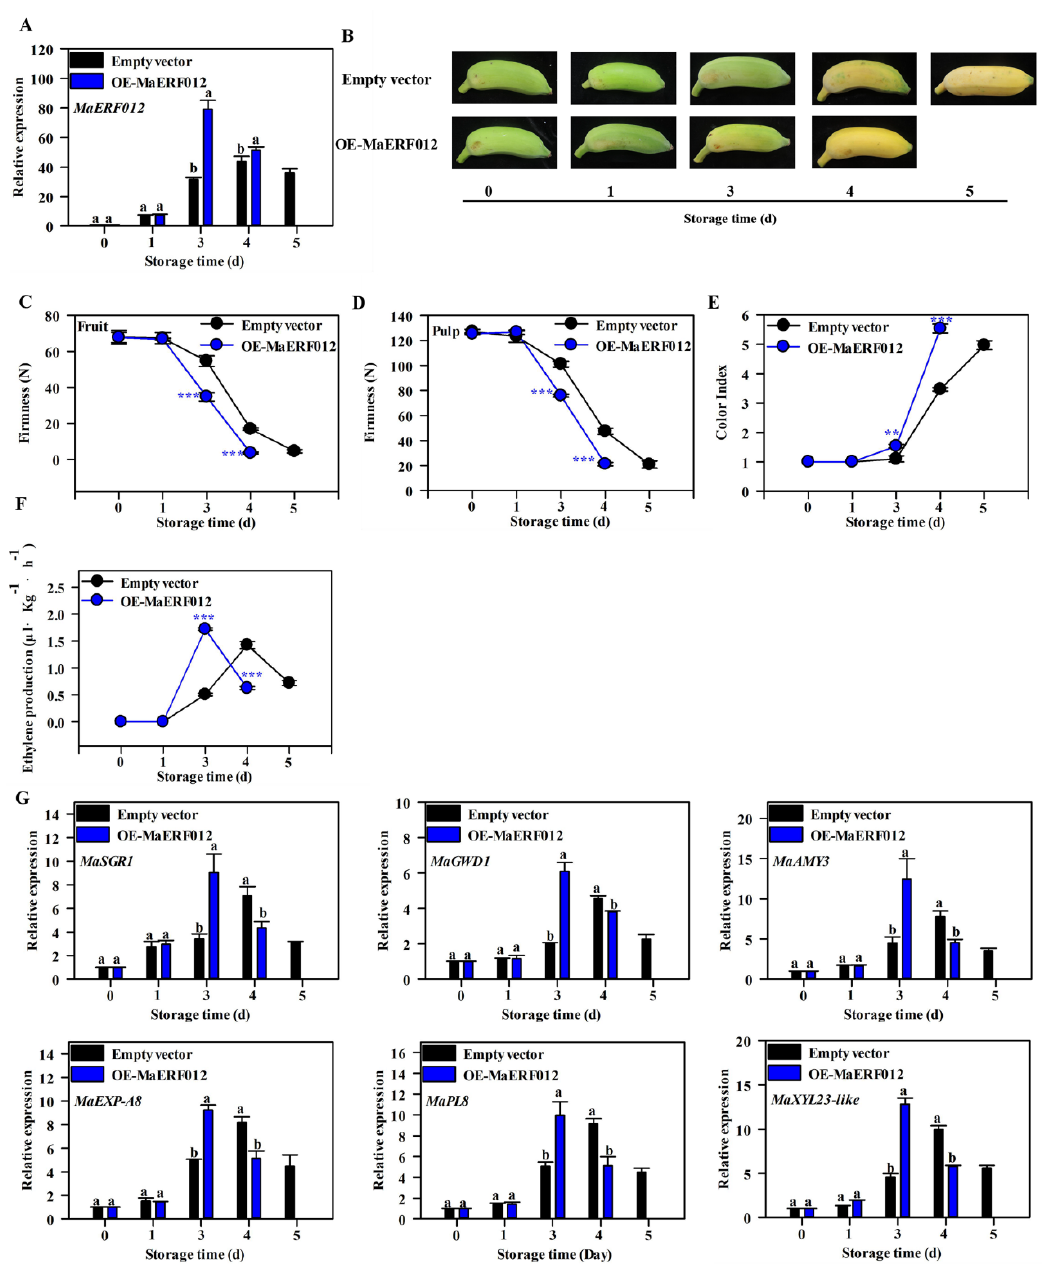
Figure 5. MaERF012 overexpression promotes fruits ripening in ‘Fenjiao’ banana. ( A ) In ‘Fenjiao’ banana, the expression of MaERF012 for MaERF012 -overexpressing and empty vector lines was measured by RT-qPCR. The expression data for the empty vector was set as 1. Different letters indicate significant difference ( p < 0.05). ( B ) ‘Fenjiao’ banana ripening process of MaERF012 -overexpressing and empty vector lines. ( C – F ) Changes in fruit ( C ) and pulp ( D ) firmness, color index ( E ), and ethylene production ( F ) during fruit ripening. Asterisks (** and ***) indicate significant differences at a level of p < 0.01 and p < 0.001, respectively. ( G ) MaERF012 overexpression activates the expression of one Chl degradation, two starch degradation, and three cell wall degradation genes. Different letters indicate significant difference ( p <